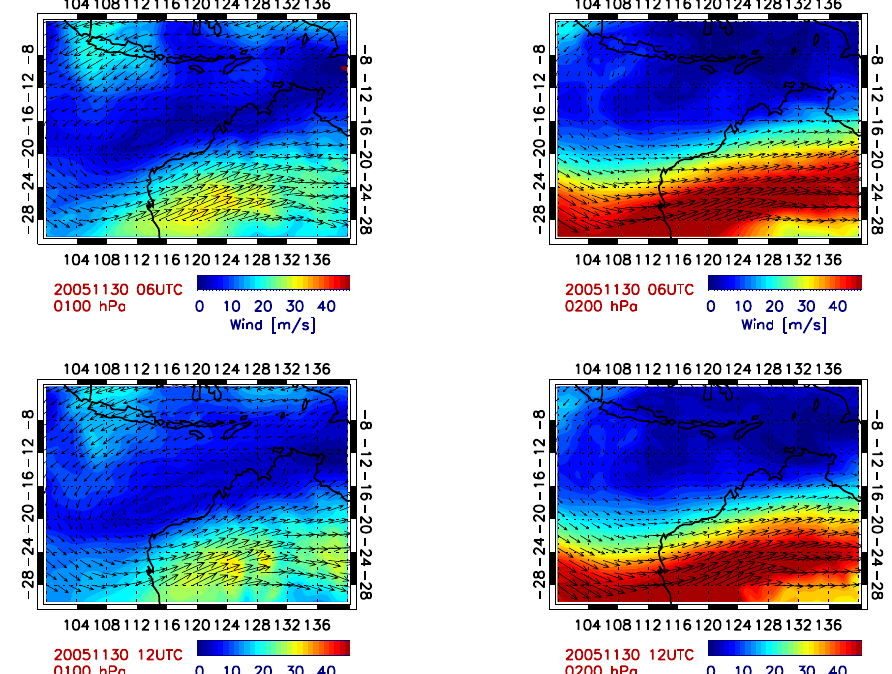
Figure 5. Wind fields from ECMWF at 100hPa (left panels) and 200hPa (right panels) at 15:30LT (upper panels) and 21:30LT (lower panels).